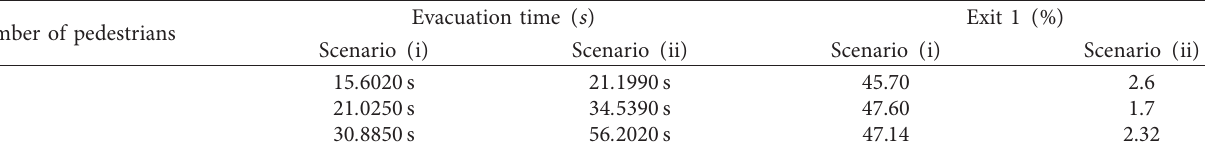
Figure 3: A plot of the ball radius R versus the average evacuation time. Table 1: The average evacuation time and the percentage of pedestrians who move out through Exit 1. The source is in the middle of the room in scenario ( i ) and in front of Exit 1 in scenario ( ii ) .